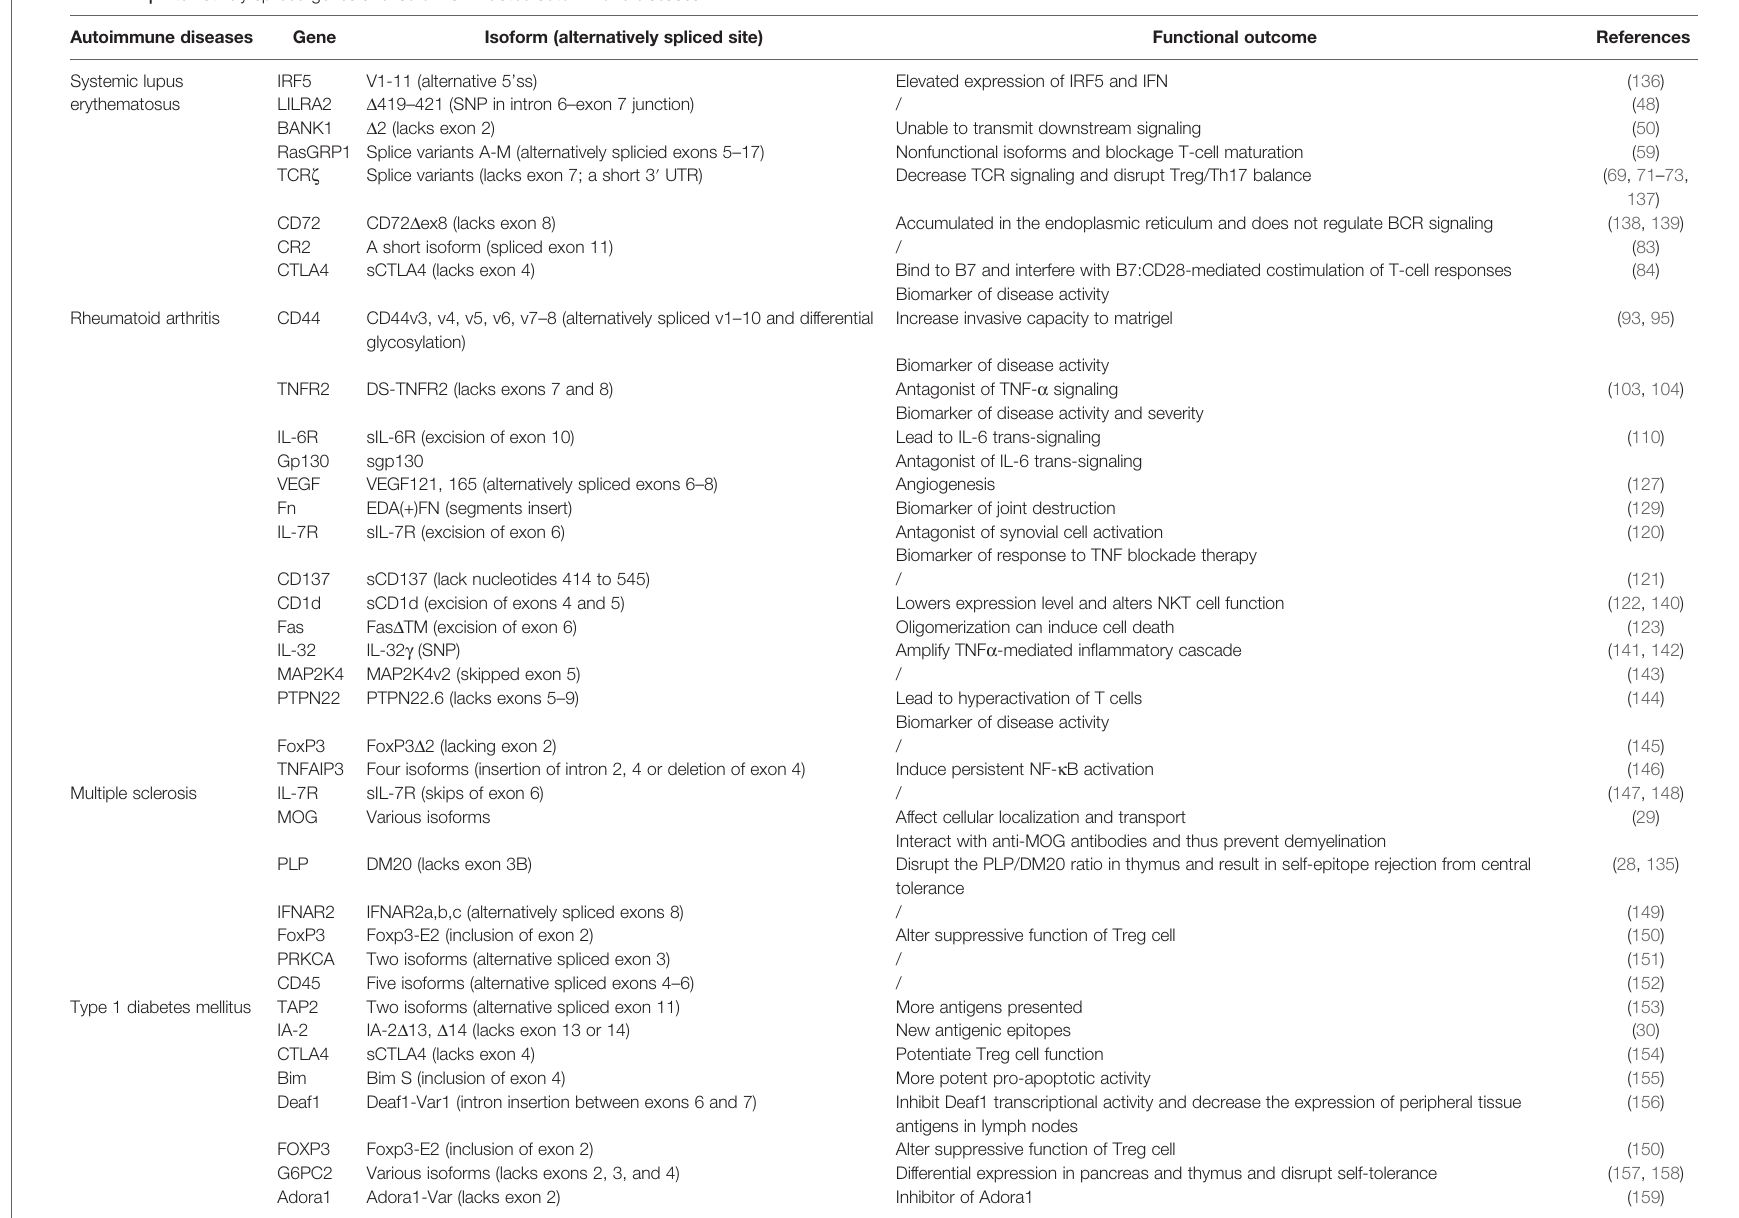
TABLE 1 | Alternatively spliced genes and isoforms in related autoimmune